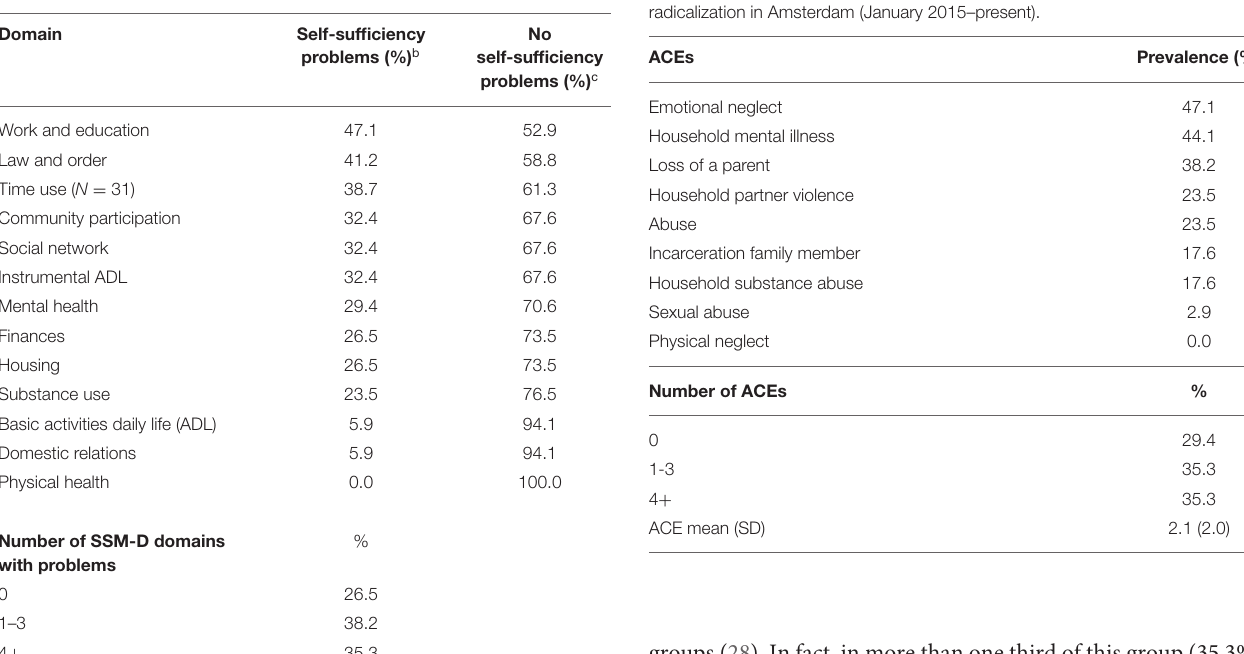
TABLE 4 | Self-sufficiency problems a in subjects ( N = 34) included in a case-based approach of radicalization in Amsterdam (January 2015–present).